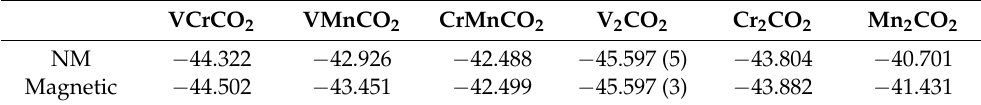
Table 2. Total energy of spin-polarized and non-spin-polarized systems. NM stands for non-spin- polarized system, magnetic stands for spin-polarized systems, the unit of total energy is eV/u.c (unit